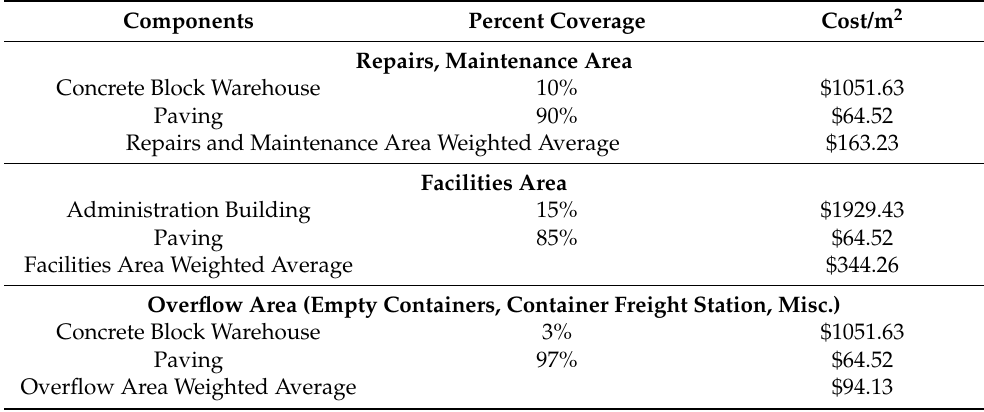
Table 4. Secondary yard cost components per percentage coverage (2012 US